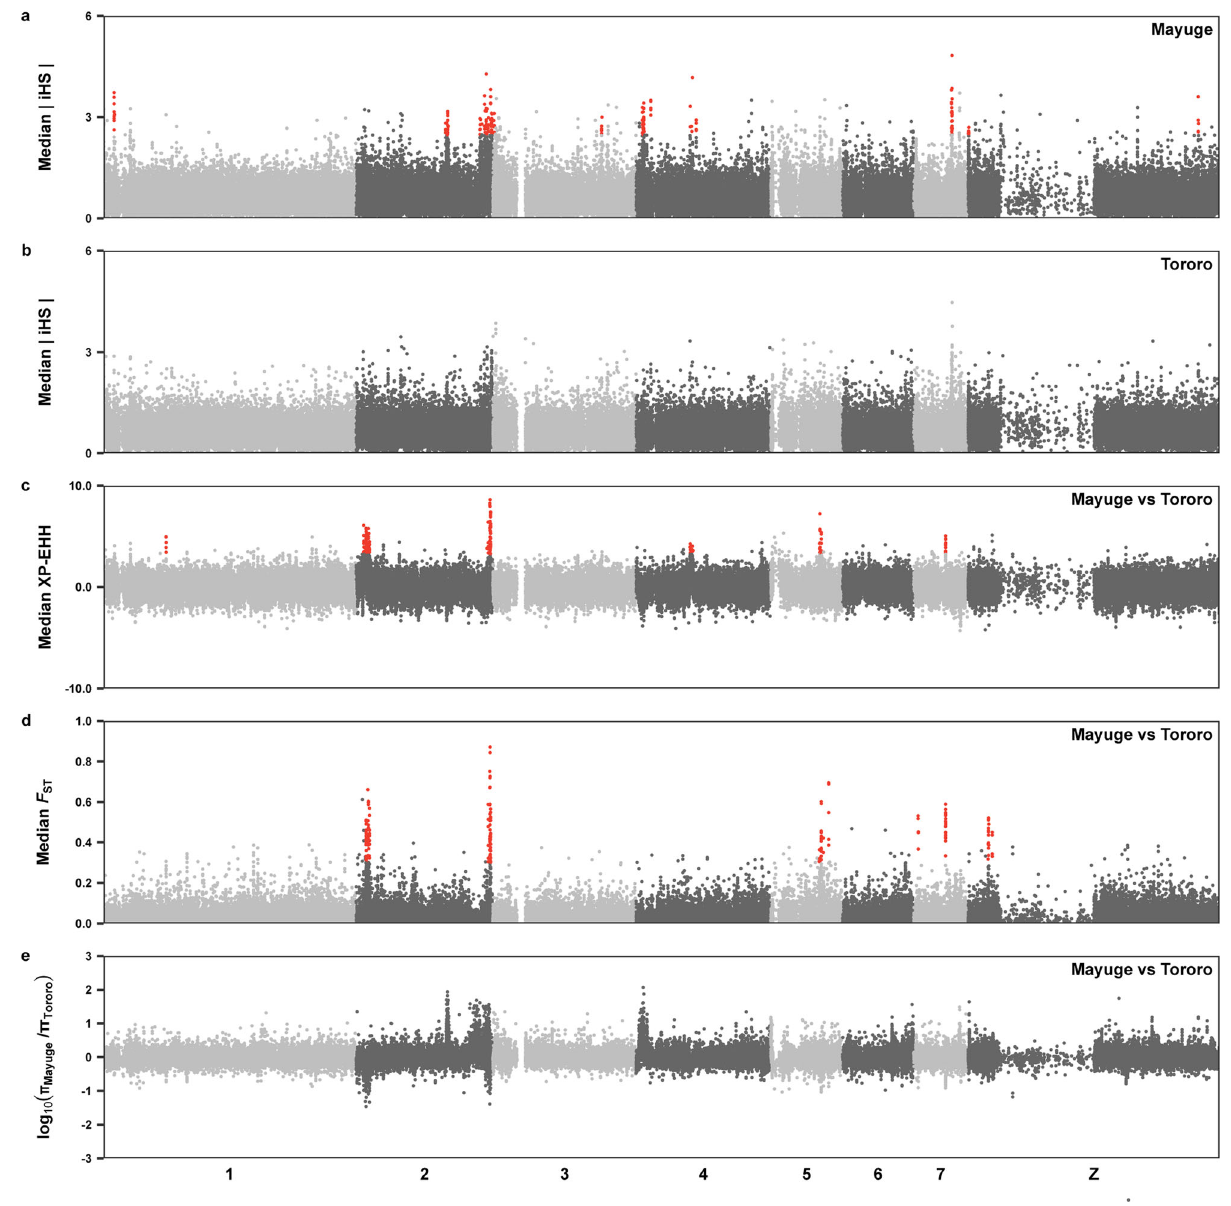
Fig. 4 Signatures of recent selection. a Genome-wide integrated haplotype scores (iHS) within the Mayuge population ( n = 181) a region of long-term MDA pressure (8 – 9 previous annual rounds). b Genome-wide integrated haplotype scores (iHS) within the Tororo populations ( n = 17), a region of short- term MDA pressure (1 previous round with limited coverage). Points represent median values of all variants in 2 kb non-overlapping windows along the eight S. mansoni chromosomes (shown in alternating shades of grey). c Genome-wide cross-population extended haplotype heterozygosity values (XP- EHH) between populations from Mayuge district and Tororo district, calculated as the median of all variants in 2 kb non-overlapping windows. d Fixation index ( F ST ) values between populations from Mayuge district and Tororo district, calculated as the mean of F ST scores in non-overlapping 2 kb windows. e Nucleotide diversity was calculated as the mean of 2 kb windows across each chromosome for each district, the ratio between Mayuge and Tororo 2 kb windows is shown. Windows with the highest 0.25% of values in the Mayuge iHS, F ST and XP-EHH statistics (shown as red points) were used to de fi ne candidate regions of selection. Windows with a 300 kb of each other were joined into continuous regions of selection, any of those regions with <8 windows with elevated values across any statistic were discarded (Supplementary Data